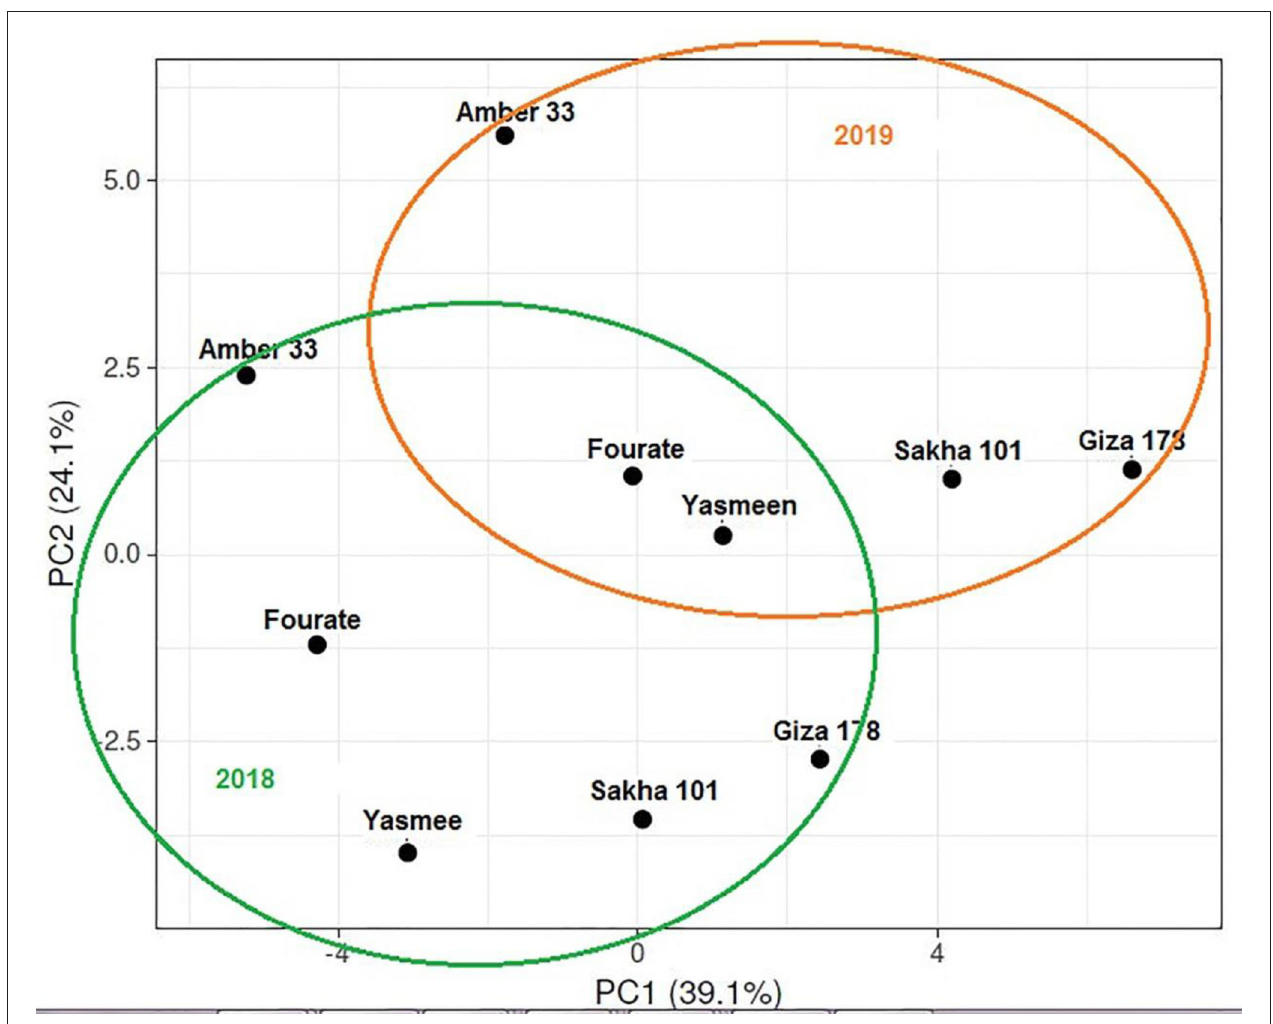
FIGURE 5 | Principle component analysis (PCA) for all physiological traits and kernel quality traits of five rice genotypes under Zn treatments for two seasons (2018 and 2019).